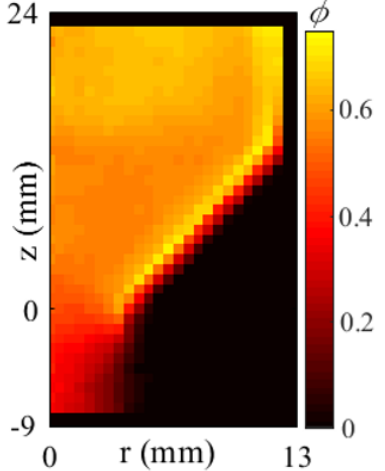
Fig. 3. The radially averaged solid fraction map of the 30° hopper during steady flow.